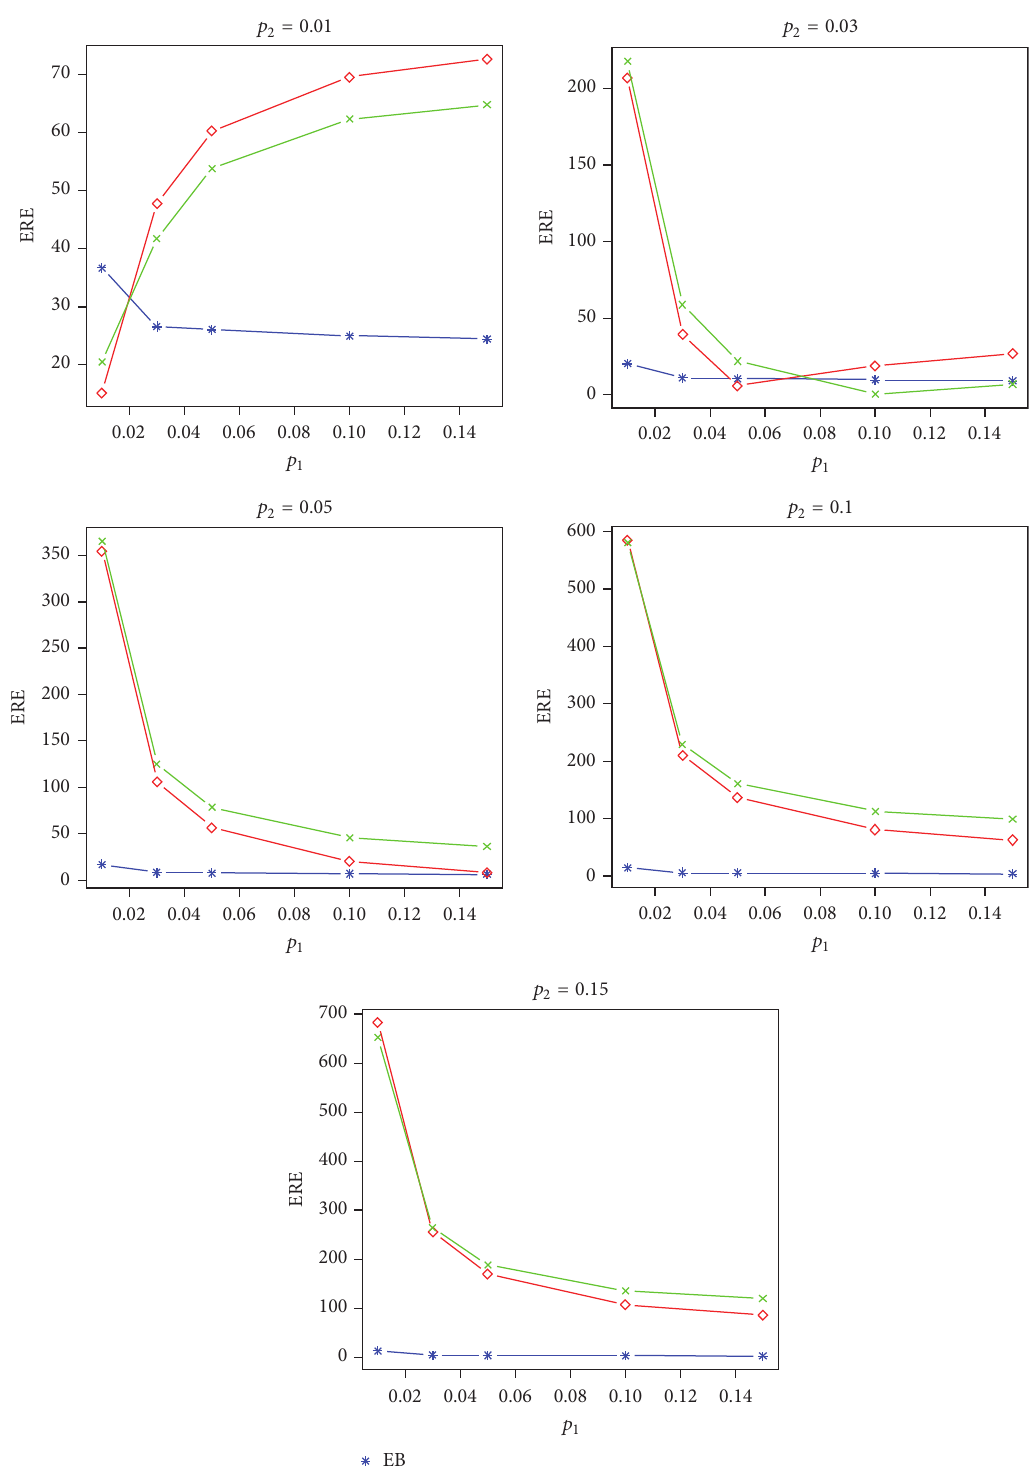
Figure 1: The percentages of ERE for odds ratio estimation using EB, MMLE, and MMUE when (𝑛 1 ,𝑛 2 ) = (10,